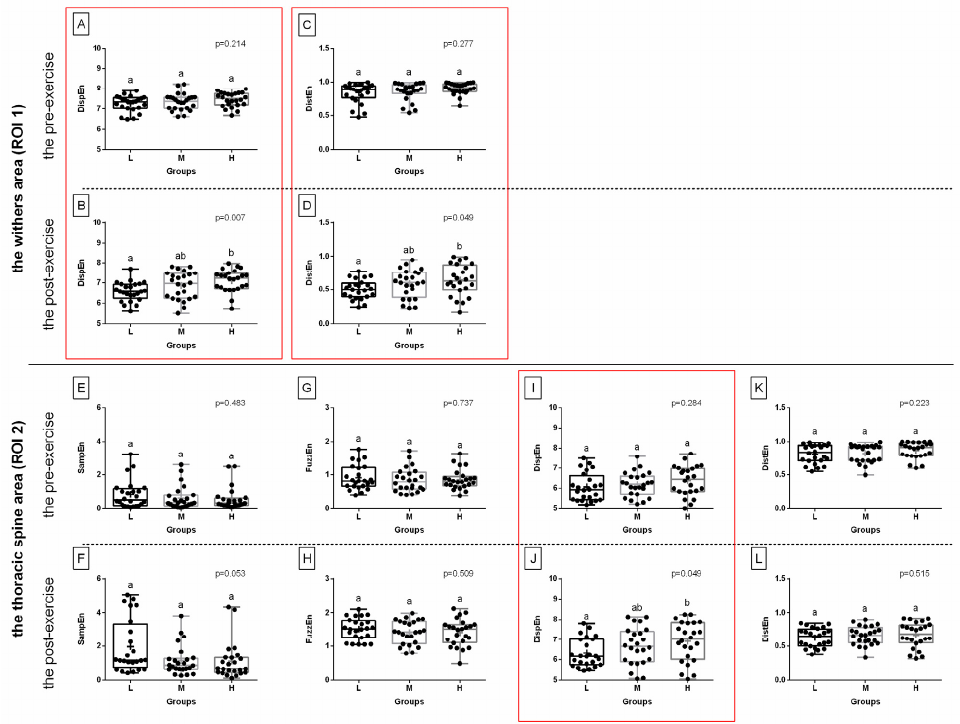
Figure 3. The comparison of the selected entropy measures in the red color component between light (L), moderate (M), and heavy (H) rider groups. The withers area (ROI 1) ( A – D ) and the thoracic spine area (ROI 2) ( E – L ) are separated by a solid horizontal line. The images obtained pre-exercise ( A , C , E , G , I , K ) and post-exercise ( B , D , F , H , J , L ) are separated by dashed horizontal lines. The following entropy measures are considered: DispEn—two-dimensional dispersion entropy ( A , B , I , J ), DistEn— two-dimensional distribution entropy ( C , D , K , L ), SampEn—two-dimensional sample entropy ( E , F ), FuzzEn—two-dimensional fuzzy entropy ( G , H ). Data are presented using minimum and maximum values, lower and upper quartiles, and median. The mean value is marked by a cross. Differences between rider groups were indicated with individual p -values when p < 0.05. Different superscripts on each plot were statistically different. Measures that differ between rider groups (L, M, H) are marked with a red